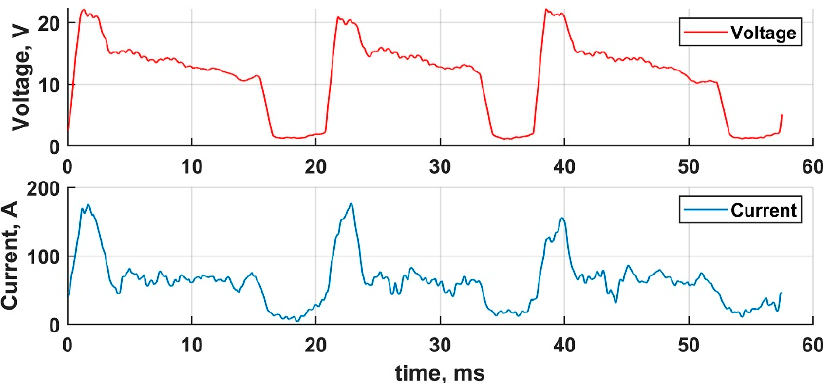
Figure 1. Three definitive CMT cycles.